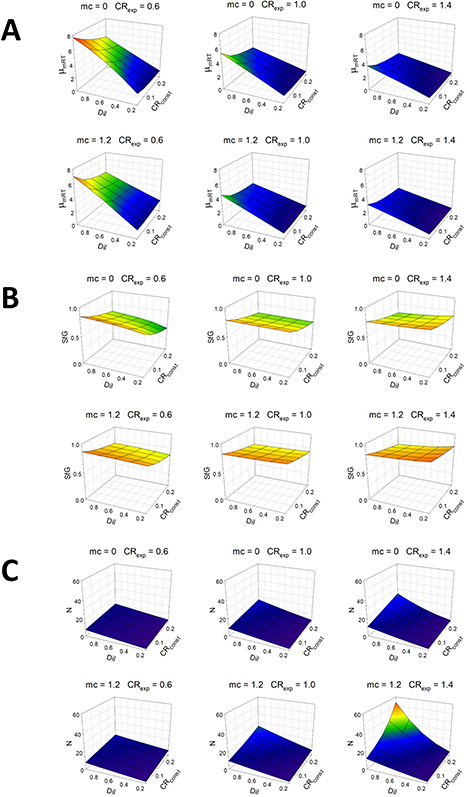
Mesh plots for Phyto growing in a N-limited chemostat where the realized growth rate equals the dilution rate (Dil). Outputs from 150 simulations were run to equilibrium over 2000 days in a factorial design with varying dilution rate (Dil; d−1), catabolic respiration constants (CRconst and CRexp; dimensionless) and mortality coefficient (mc; dimensionless); see Table I and Supplementary Table for parameter values. Shown are mesh surface plots for maximum growth rate at the reference temperature (μmRT, panel A; d−1), SfG (panel B; dimensionless quotient) and residual nutrient (N, panel C; mgN m−3).